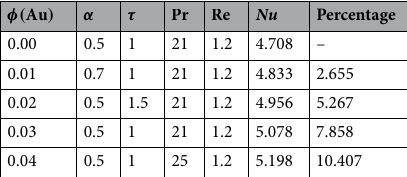
Table 6. Percentage enhancement for different volume fraction of